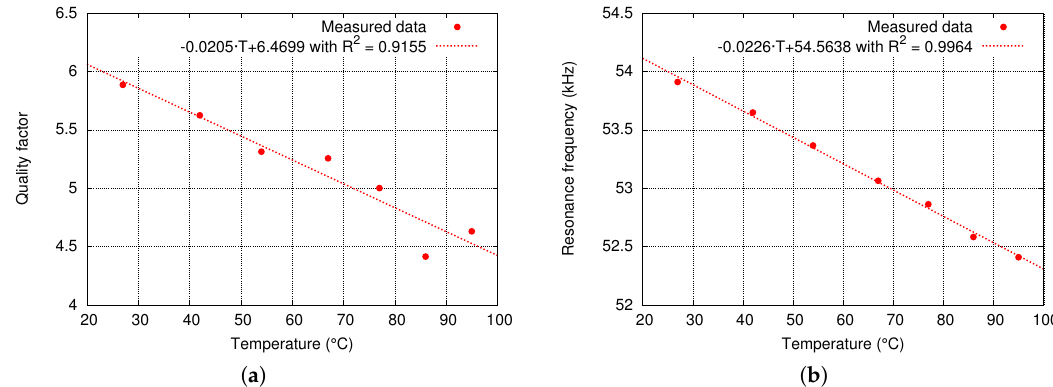
Figure 13. Measured quality factor variation ( a ) and resonance frequency ( b ) as a function of temperature at ambient